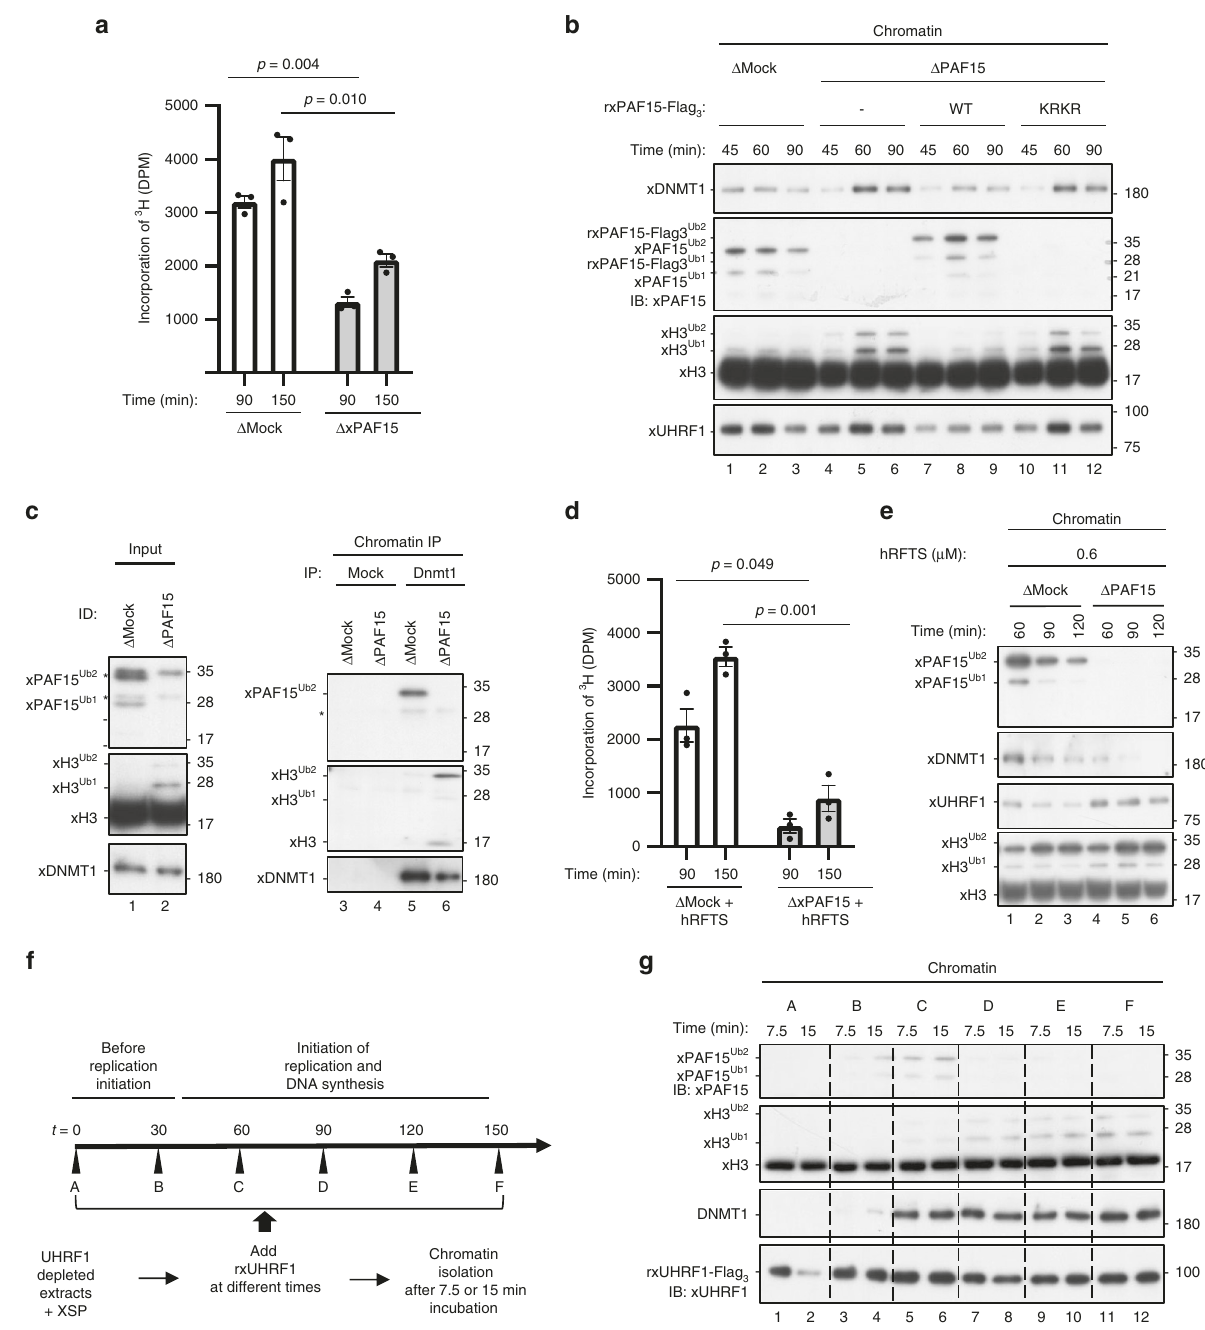
Fig. 4 xPAF15Ub2 promotes recruitment of xDNMT1 and maintenance of DNA methylation. a , d Sperm chromatin was added to either mock- or xPAF15- depleted extracts containing radiolabeled S-[methyl- 3 H]-adenosyl-L-methionine in the absence ( a ) or presence of 0.6 μ M hRFTS ( e ). The ef fi ciency of DNA methylation was measured at the time points indicated. Bar graphs depict the quanti fi cation of incorporated SAM into genomic DNA with mean and SEM from three independent experiments. Statistical signi fi cance was determined using Student ’ s t test. b , e Sperm chromatin was added to mock- or xPAF15-depleted interphase extracts in the absence ( b ) or presence ( f ) of hRFTS. PAF15-depleted extracts were supplemented with either buffer alone (lanes 4 – 6), puri fi ed wild-type xPAF15-Flag 3 or K18R/K27R(KRKR) mutant xPAF15-Flag 3 (320 nM fi nal concentration, lanes 7 – 9 or 10 – 12, respectively) in the experiment described in b . At the indicated time points, chromatin fractions were isolated and subjected to immunoblotting using the antibodies indicated. For the PAF15 levels in extracts, see Supplementary Fig. 2a. c Sperm chromatin was replicated in mock- or PAF15-depleted interphase egg extracts. Isolated and solubilized chromatin proteins were subjected to immunoprecipitation using an anti-xDNMT1 antibody. The resultant immunoprecipitates were analyzed by immunoblotting using the indicated antibodies. Asterisks, non-speci fi cally detected proteins. f Schematic of experimental approach to test the differential regulation through UHRF1 during the progression of S phase. g Sperm chromatin was added to xUHRF1- depleted extracts and incubated for 0, 30, 60, 90, 120, or 150 min. Extracts were then supplemented with recombinant xUHRF1-Flag 3 and further incubated for 7.5 or 15 min. Chromatin fractions were isolated and chromatin-bound proteins were analyzed by immunoblotting using the antibodies indicated. Source data are provided as a Source Data fi